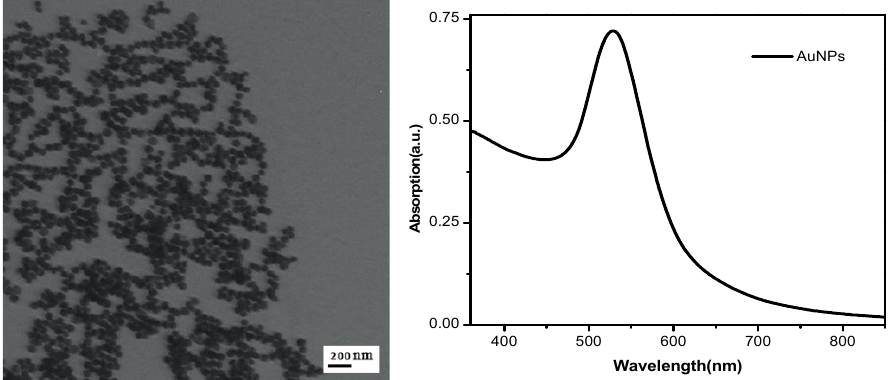
Fig. 2. TEM image and UV-Visible spectra of colloidal AuNPs with average diameter of AuNPs Fig. 2: TEM image and UV-Visible spectra of colloidal AuNPs with average diameter of 20nm.